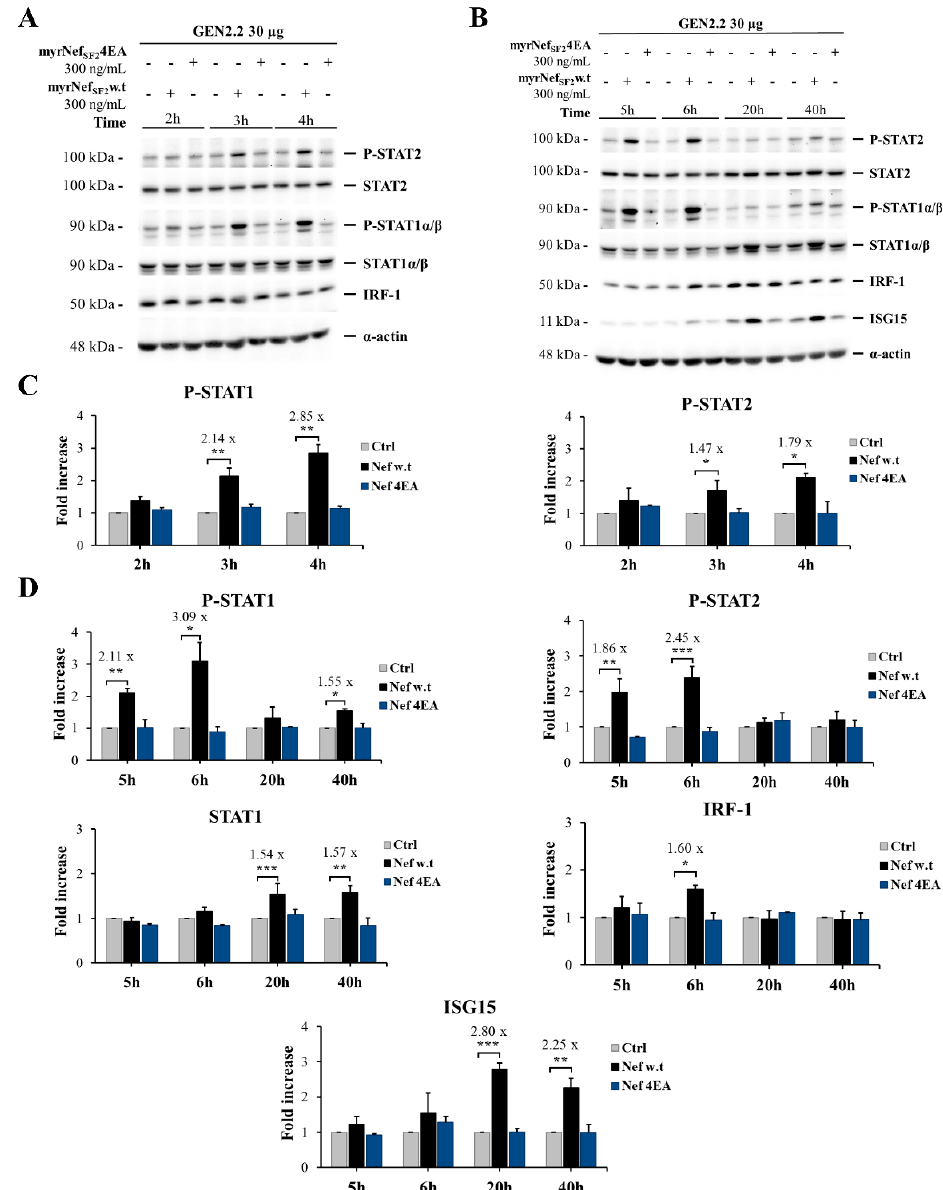
Figure 5. HIV-1 myrNef SF2 w.t protein induces STAT1 and 2 activation and increases expression of proteins transcriptionally regulated by their activation (i.e., STAT-1, IRF-1 and ISG15). GEN2.2 cells were seeded at 2 × 10 6 cells/each sample in a 24-well plate and treated with 300 ng/mL of myrNef SF2 w.t or myrNef SF2 4EA or left untreated (Ctrl) using two different time-courses: the shorter one (2–4 h) represented in panels A and C, and the longer one (5–40 h) reported in panels B and D. Cells were lysed and 30 µg of proteins of each cell extract were run on 9–13.5% SDS-PAGE gel. ( A , B ) Representative examples of three independent Western blots are shown. Anti- α -actin was used as an internal control of the loaded samples. ( C , D ) Densitometric analyses of three independent Western blotting experiments. The band density ratios of P-STAT1, P-STAT2, ISG15 and IRF-1, normalized relative to actin levels, are reported in the histograms. P-STAT1, P-STAT2, ISG15 and IRF-1/actin ratios in control cells (Ctrl) were set to 1. Fold increases of each analysed protein were calculated and reported as means ± S.D. One-way ANOVA test; *, p < 0.05; **, p < 0.01; ***, p < 0.005 vs. respective Ctrl.